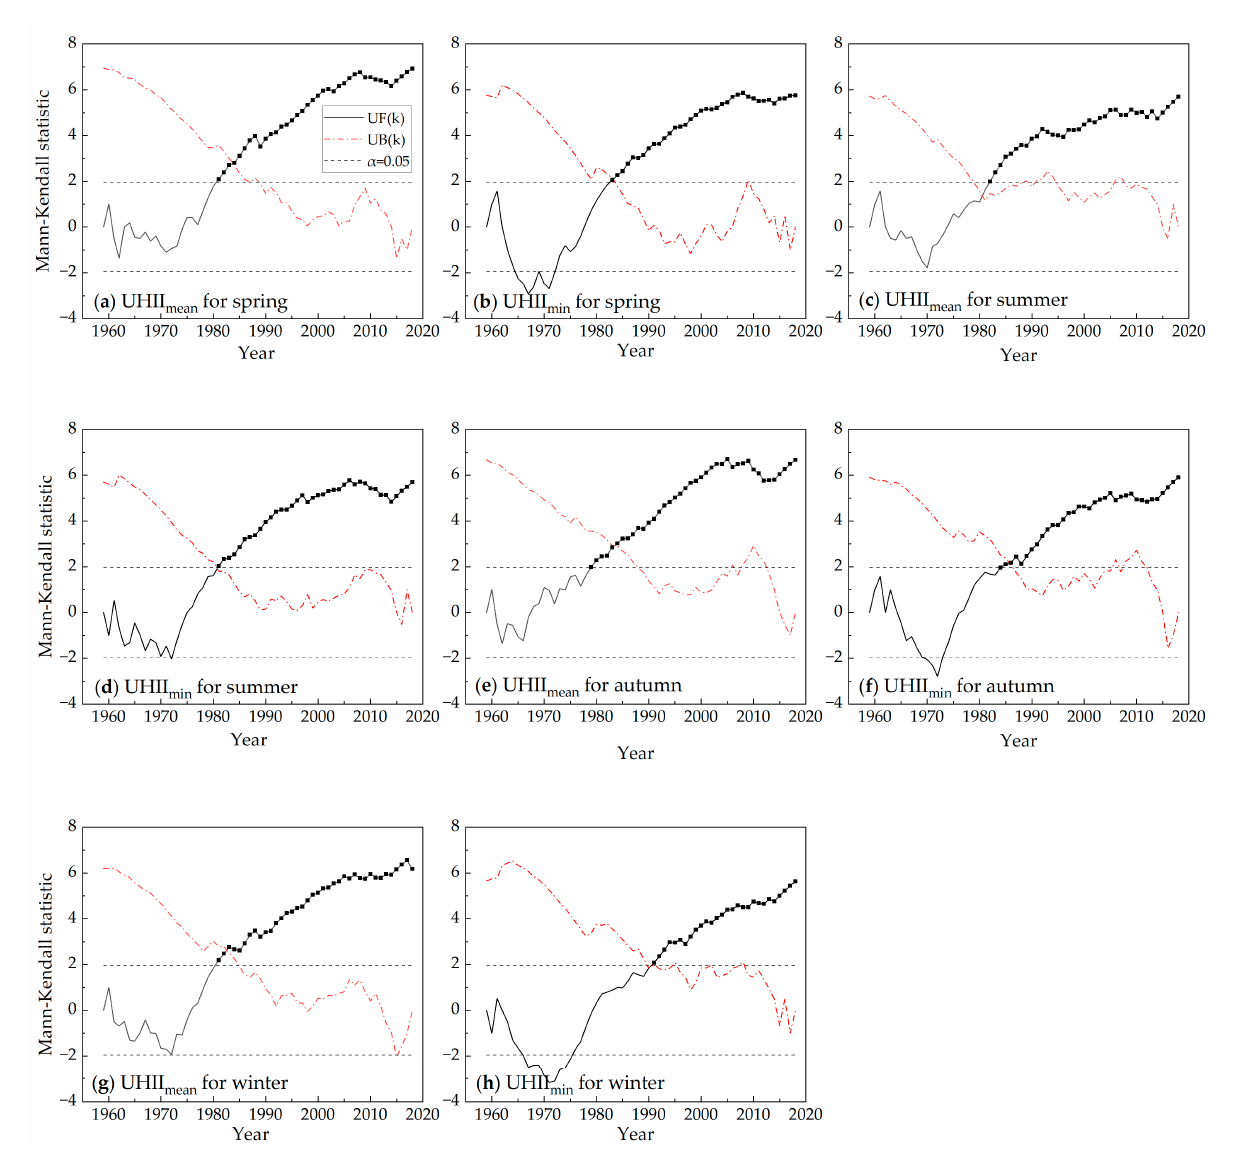
Figure 9. The Mann–Kendall statistic curves during the period of 1959–2018: ( a ) UHII mean for spring; ( b ) UHII min for spring; ( c ) UHII mean for summer; ( d ) UHII min for summer; ( e ) UHII mean for autumn; ( f ) UHII min for autumn; ( g ) UHII mean for winter; ( h ) UHII min for winter.